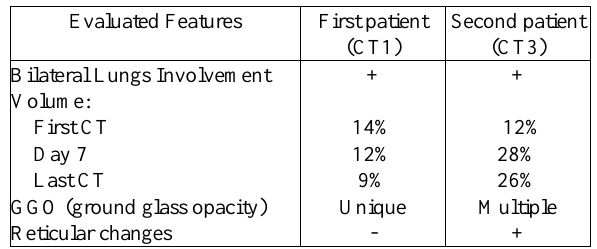
Table 1. The location, morphology and volume of pulmonary